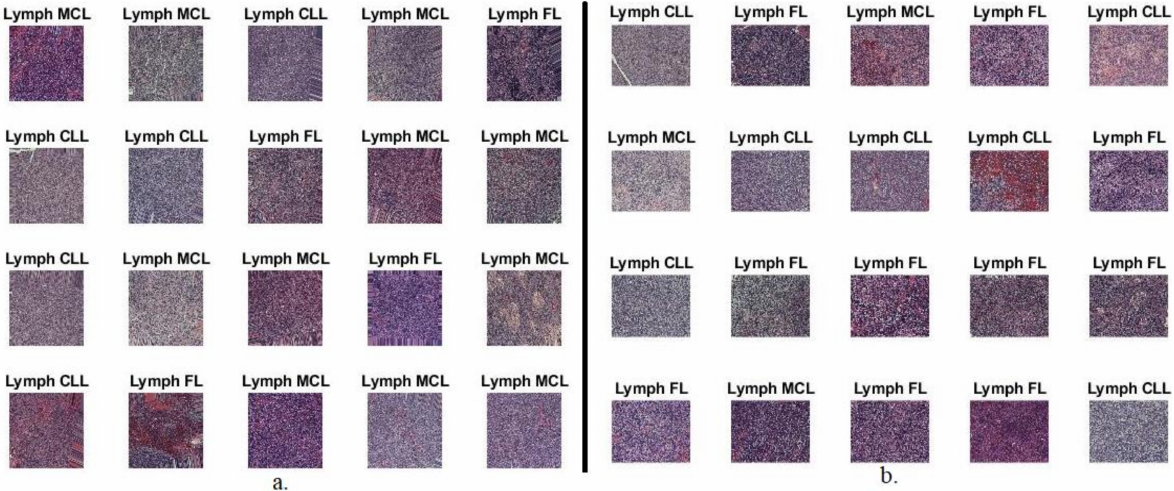
Figure 2. Some samples of images of malignant lymphoma: ( a ) First dataset and ( b ) Second dataset.